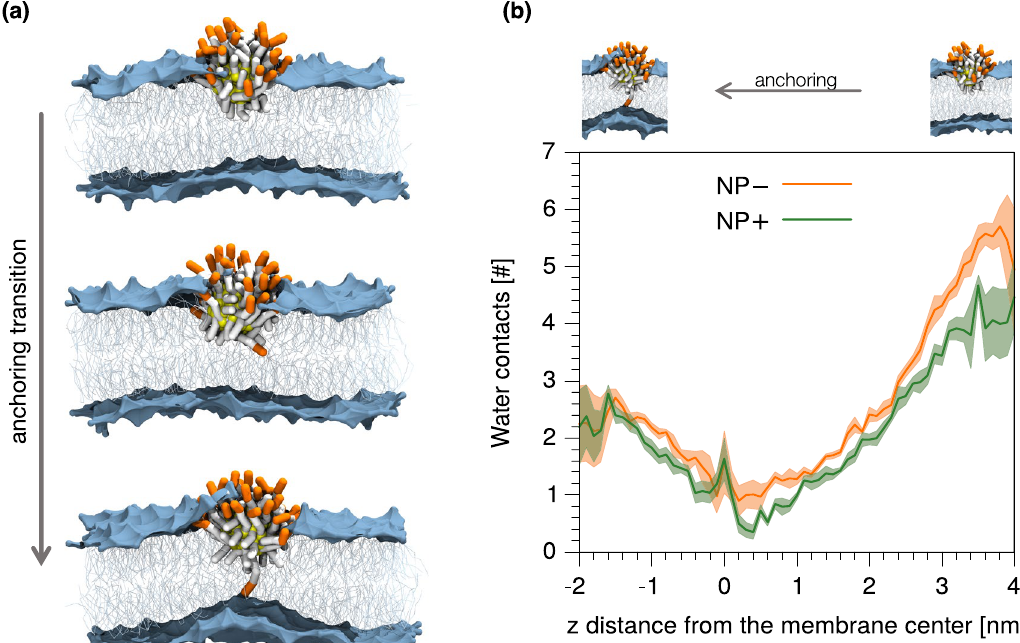
Figure 3. NP− and NP+ share the same mechanism of interaction with the membrane. ( a ) A charged ligand (orange beads represent the anionic terminal groups) makes the anchoring transition. Color code as in Fig. 2a. The same mechanism of interaction takes place with charged ligands showing cationic terminal groups. ( b ) The time average number of contacts between the biased ligand terminal and coarse-grained water beads as a function of the z distance between the terminal and the COM of POPC bilayer. The shaded area corresponds to the standard deviation associated to the time simulated the NP-membrane interaction and sampled the free energy surface of the NP-membrane complex by means of unbiased MD and biased metadynamics 55 calculations. NP− and NP+ share the same mechanism of interaction with the membrane. Our simulations show that the interaction of charged Au NPs with lipid bilayers is a process that involves the transition between different meta- stable states 40 . One transition, in particular, is interesting for our comparison between NP− and NP+. This transi- tion, which we refer to as the “anchoring transition” and is shown in Fig. 3a, requires that the charged ligands of the NP, initially bound to the headgroup region of the entrance leaflet, cross the hydrophobic membrane core to bind to the distal leaflet. We previously showed that, for NP− with a patched surface ligand arrangement 54 , the charged ligand translocation can involve significant membrane deformation and transient membrane poration. Here we compare this step of the NP-membrane interaction for NP− and NP+ with a random surface arrange- ment of charged and hydrophobic ligands. As the transition requires the charged ligands to overcome a significant free energy barrier, the process cannot be observed during unbiased MD runs. We thus use metadynamics 55 to accelerate the transition. In this set up, the dynamics of a single charged terminal of one ligand is biased along the reaction coordinate, which is the z component of the distance between the charged group and the center of mass (COM) of the membrane, to favor the ligand translocation across the membrane. More details on the metadynamics 55 set up are reported in the “Methods” section. The visual inspection of the biased trajectories suggests that both the negatively and the positively charged ligand translocations induce significant membrane deformations, as shown in Supplementary Figure S5. For NP−, in six out of eight translocation processes we observed at least one water bead being transferred across the membrane together with the anchoring ligand. For NP+, the same happened in eight out of eight transitions. Figure 3b shows the average number of contacts between the charged terminal of the biased ligand and water, as a function of the reaction coordinate. When the charged ligand terminals approach the COM of the membrane, they are hydrated and the number of water beads surrounding the ligand is similar for NP− and NP+. More quantitatively, we used metadynamics 55 to calculate the free energy barriers for the translocation of the negatively and positively charged ligands (bound to the NP as in Fig. 3a) across the membrane 54 . Figure 4a shows the potential of mean force obtained for NP− and NP+. Again, no significant difference is observed for the anchoring barriers of the oppositely charged Au NPs, which set to 76 ± 6 kJ/mol for NP− and 77 ± 5 kJ/ mol for NP+. NP− and NP+ thus share the same molecular mechanisms and energetics of interaction with the POPC bilayer. The presence of calcein within the liposome does not affect the mechanism and the energetics of NP-membrane interaction. We developed a Martini model of the calcein dye 56 , as shown in Supplementary Figure S6. We then set-up a system consisting of two parallel bilayers and two distinct water chambers between them. In one water chamber, we dissolved calcein molecules with a concentration of 175 mM, in accordance with the experimental set-up of leakage assays. Ions and counterions were added to the solution as described in the “Methods” section. We monitored the structural properties of the bilayers, such as the area per lipid and